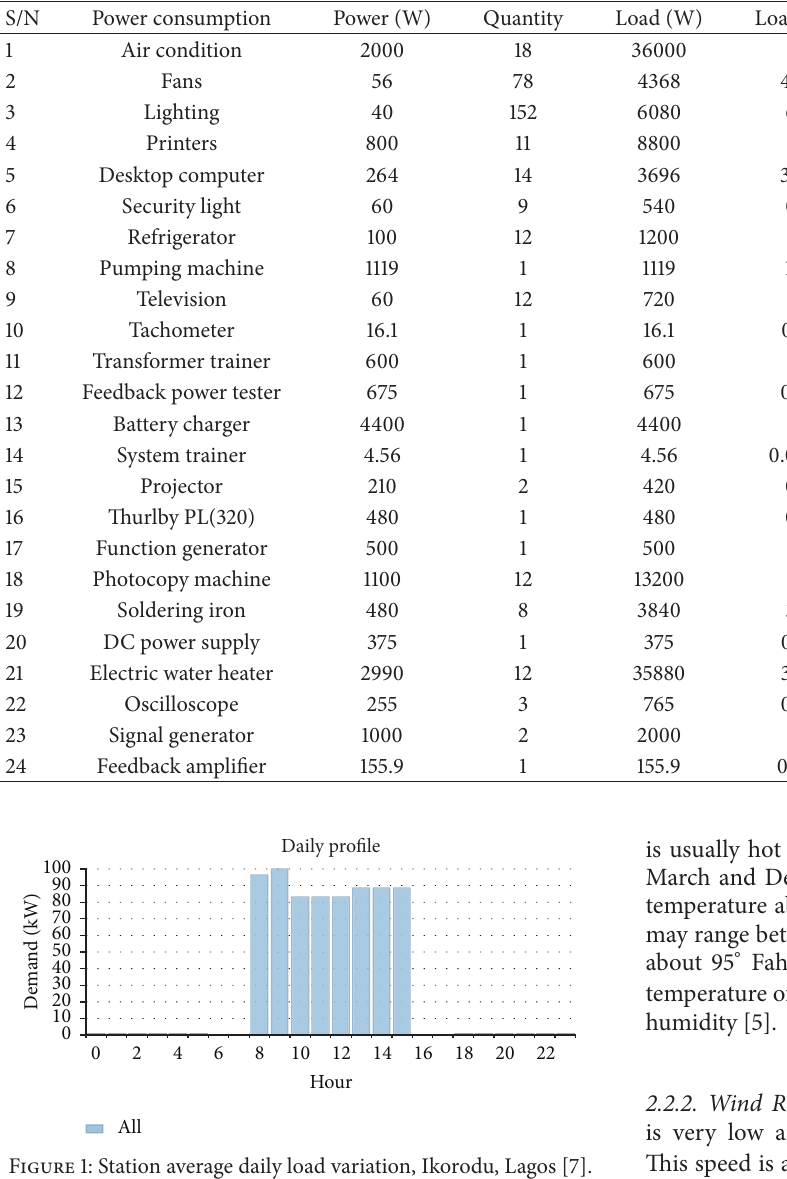
diesel generator [1]. Nigeria enjoys average daily sunshine hours of 6.25 hd −1 ranging between about 3.5 kWh m −2 d −1